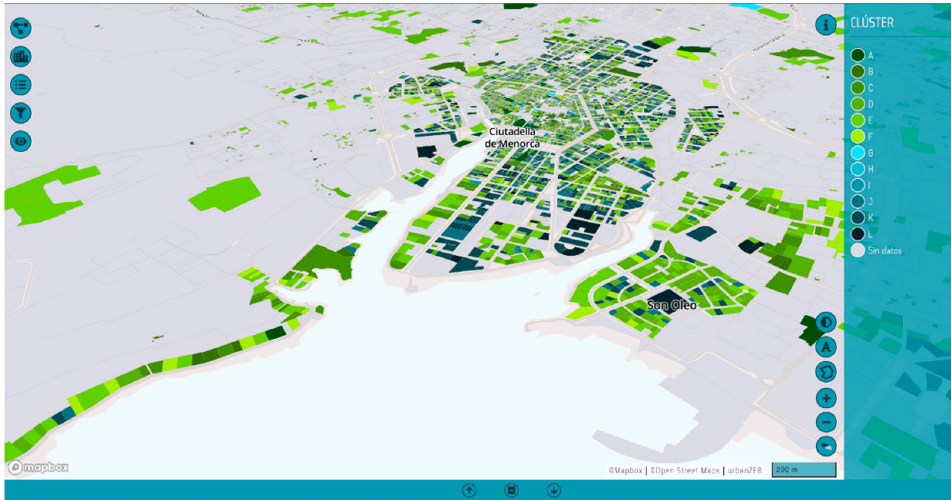
Figure 6. Main input implemented and managed in the PEDRERA model framework. The inputs are organized in compliance with the four issues, and each of them is adopted in the algorithms for the evaluation of KPIs according to the scopes. Source: PEDRERA.